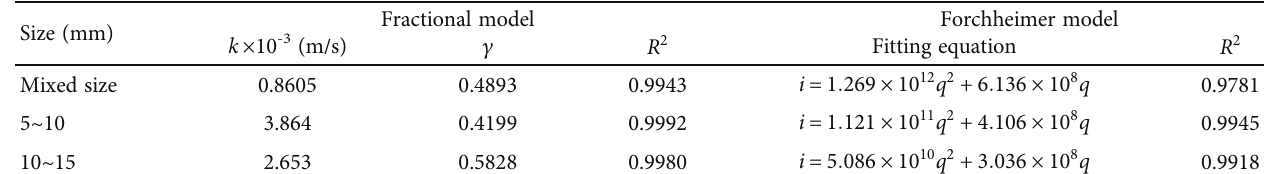
Table 2: Seepage model parameters of water storage media in underground reservoir of coal